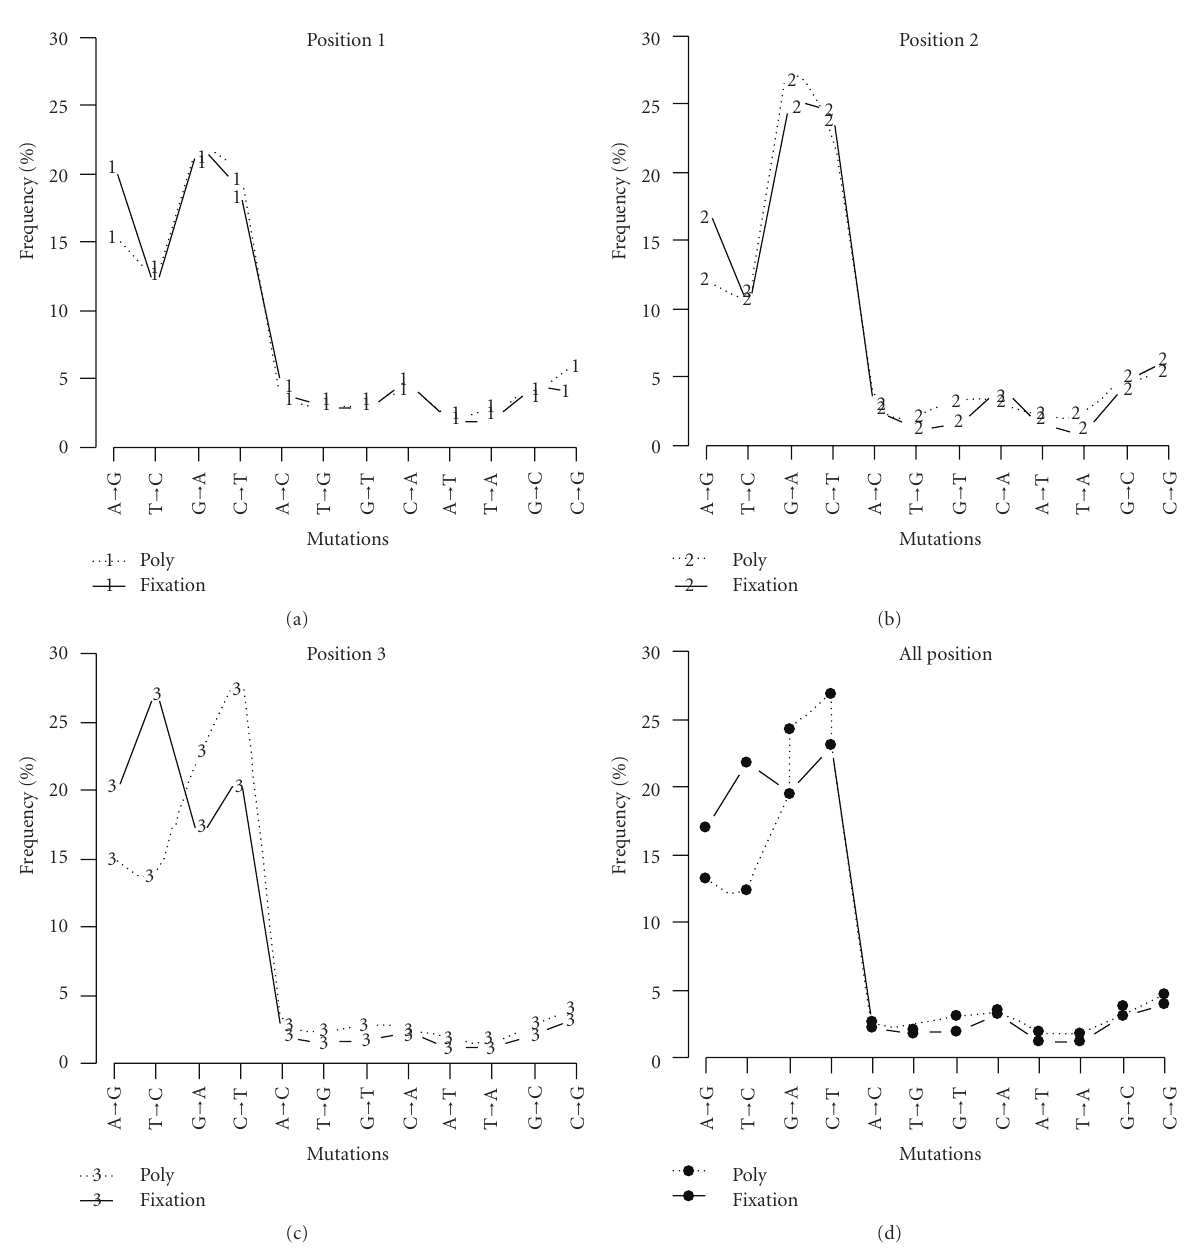
Figure 1: Normalized frequencies of nucleotide changes at the polymorphic and fixed sites in amino-acid coding regions. Figures 1(a)–1(c) show the frequencies of polymorphism (Poly) and fixation mutations at the first (a), second (b), and third (c) positions of a codon. (d) Frequency of all the mutation data. Dotted lines indicate the polymorphism and solid lines indicate the fixation.